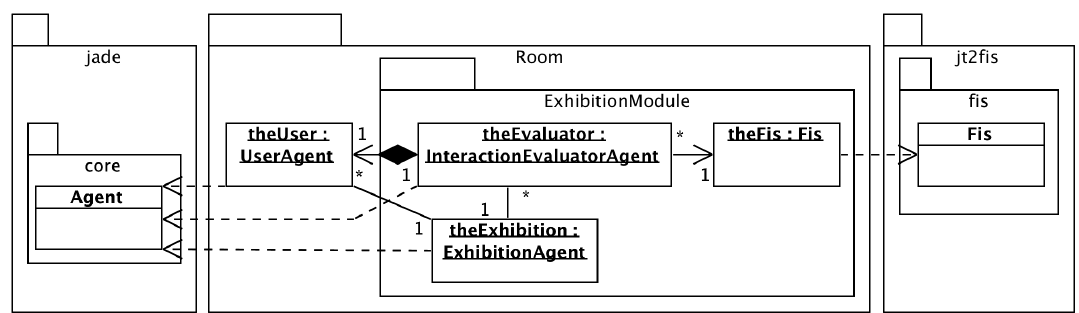
Figure 5. The agent system of the interactive museum exhibition